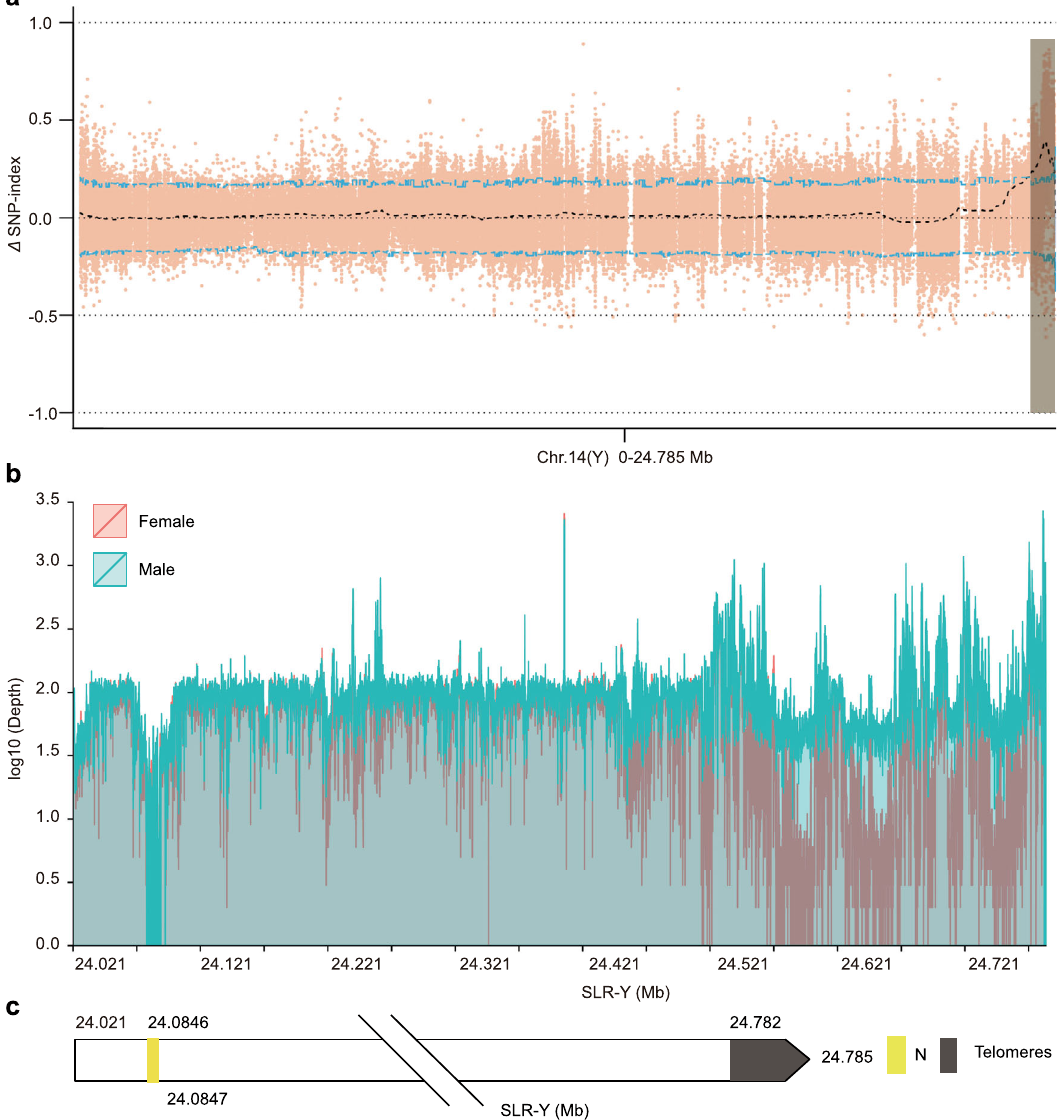
Fig. 2 Identi fi cation and characterization of the SLR in P. euphratica . a Candidate SLR (indicated by gray bar) located in the peritelomeric region of chromosome 14 (Y), as determined by Δ SNP_index analysis. b Differential depth of coverage across SLR-Y in the male genome using male and female BSA data, respectively. c Genomic diagram of SLR-Y with one distal gap represented by “ N ” (yellow) and